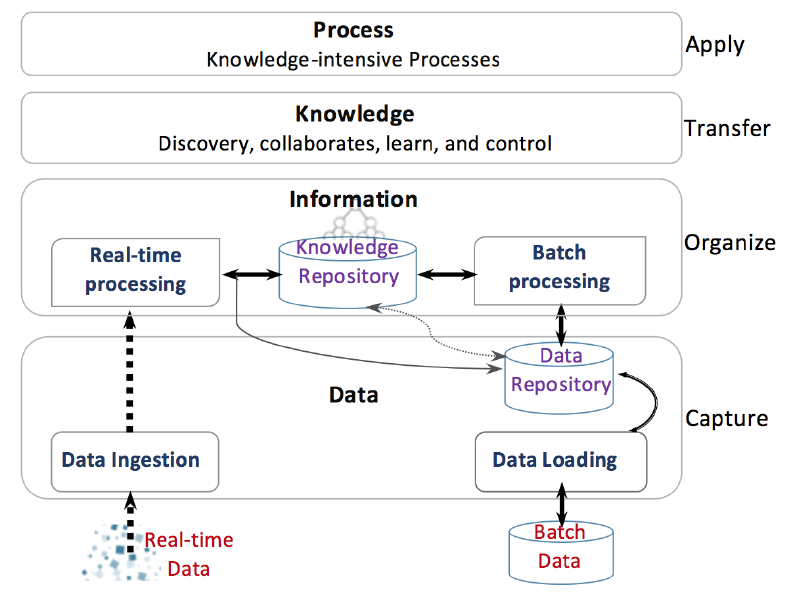
Figure 1. An architecture for big-data-driven knowledge management